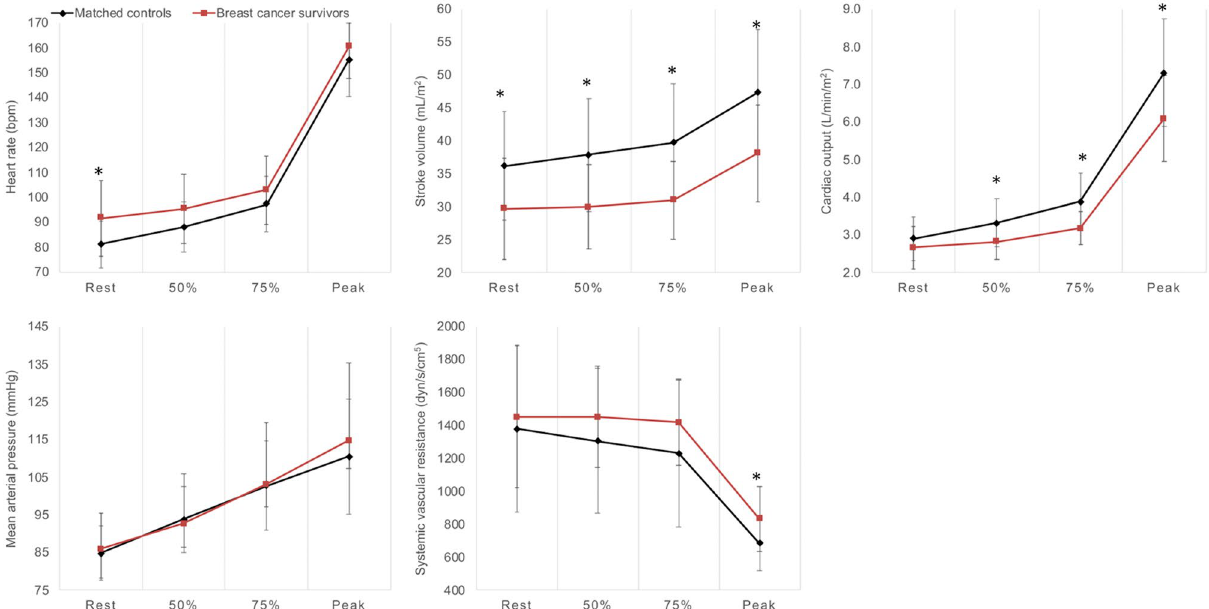
Figure 3. Bioelectrical impedance cardiography data for cycle ergometer graded exercise test in breast cancer survivors (n = 16), age- and body mass index-matched non-cancer controls (n = 16). Stroke volume and cardiac output are normalized to body surface area. *Difference between groups at p ≤